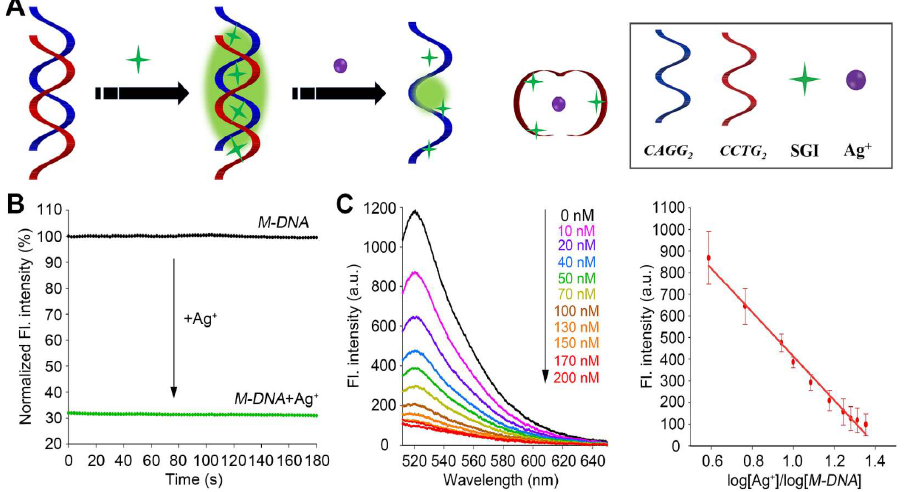
Figure 4. ( A ) Schematic of the M-DNA sensor for Ag + detection. ( B ) Normalized fluorescence intensity at 520 nm as a function of time for the M-DNA sensor in the absence of Ag + (black) and after adding 50 nM Ag + (green). ( C ) Fluorescence spectra of the M-DNA upon titrating Ag + ranging from 0 to 200 nM ( left ) and the fitting curve constructed using fluorescence intensity at 520 nm and log[Ag + ]/log[ M-DNA ] (R 2 = 0.99) ( right ). Error bars were standard deviations obtained from three replicative experiments.